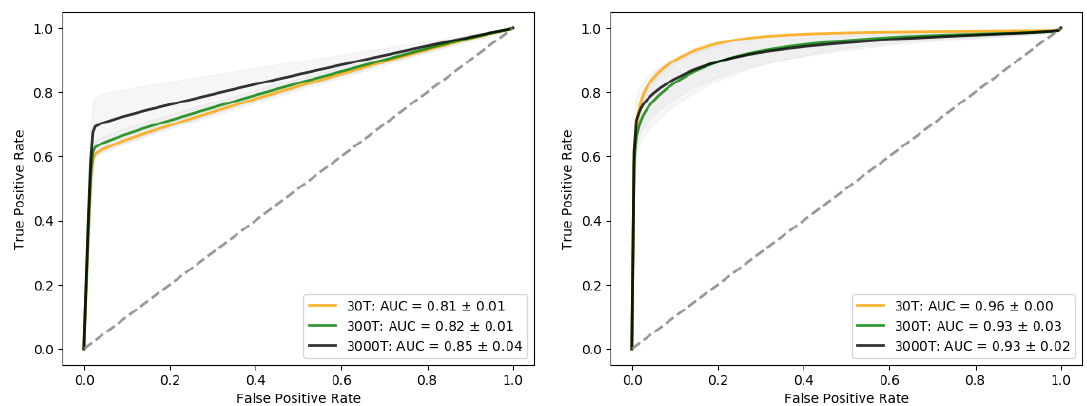
Figure 11. ( Left panel ) ROC curve with Gaussian noise is simulated with a standard deviation of 0.01 is added to the test data set. The drop of in accuracy is quite large, even with relatively low level of noise added to the test data. ( Right Panel ) ROC curve for the case where we have excluded the 300T